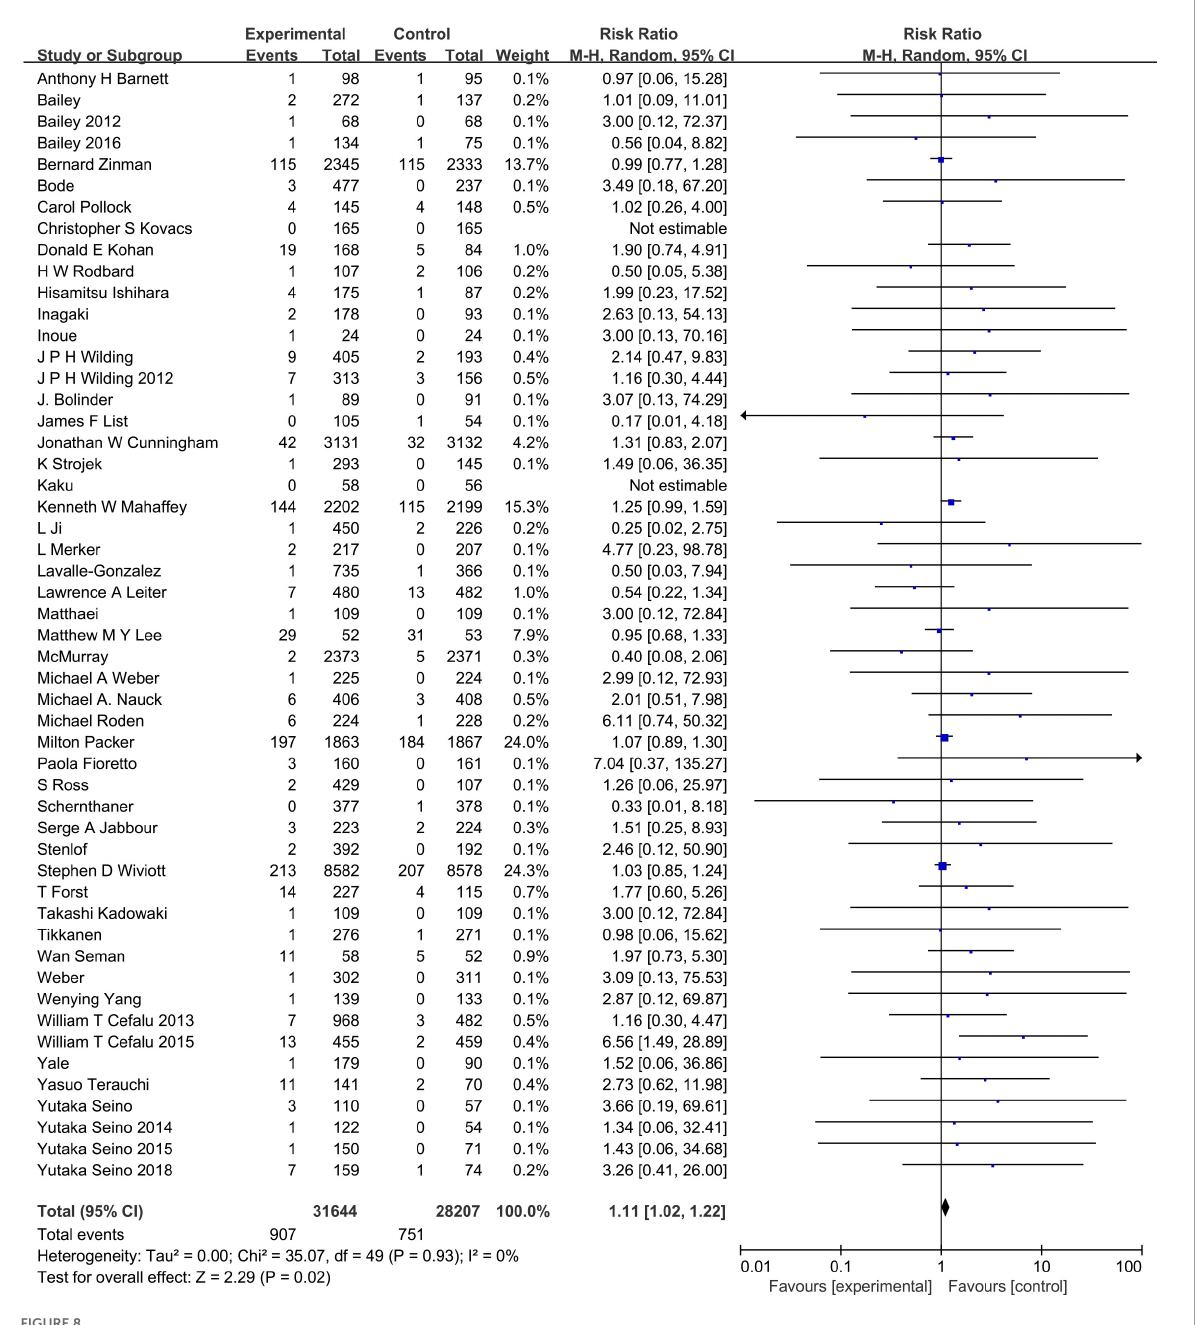
FIGURE8 Subgroup analysis of the hypovolemia events between the SGLT2 inhibitors group vs. the placebo group stratified by FDA approval dosage.